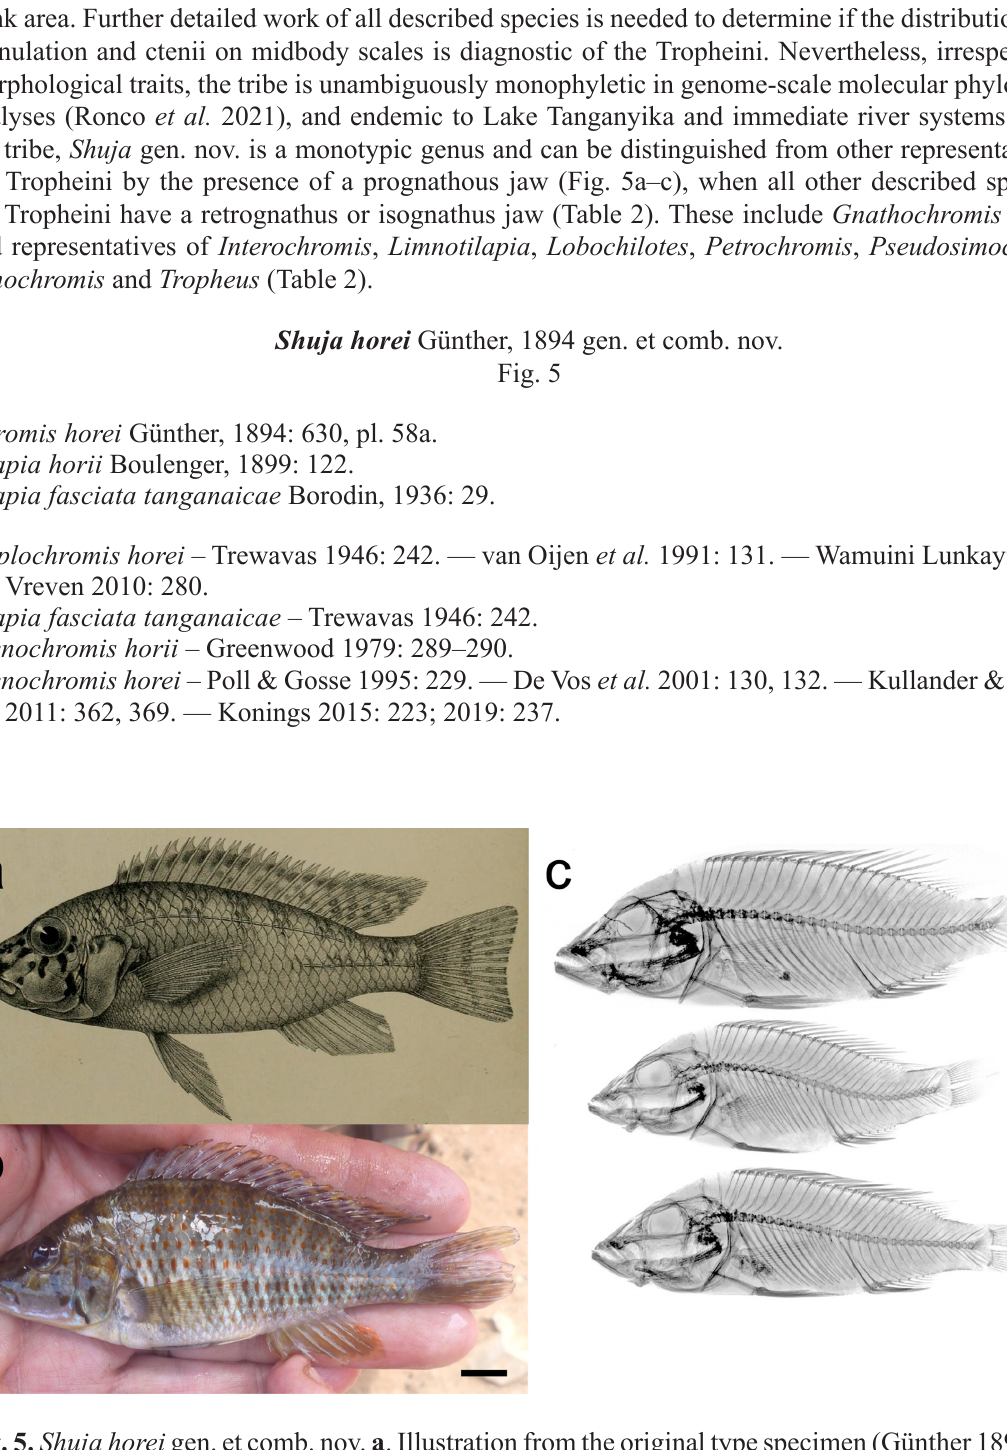
Fig. 5. Shuja horei gen. et comb. nov. a . Illustration from the original type specimen (Günther 1894). b . A freshly caught specimen collected in 2016 from the Malagarasi River, Ilagala (BMNH 2021.7.15.14). c . Radiographs of the type series (syntypes) from the Natural History Museum (BMNH 1889.1.30.13– 15). Note the prognathous jaw that distinguishes Shuja Genner, Ngatunga & Turner gen. nov. from other genera within the Tropheini Poll, 1986. Radiographs from the Natural History Museum,